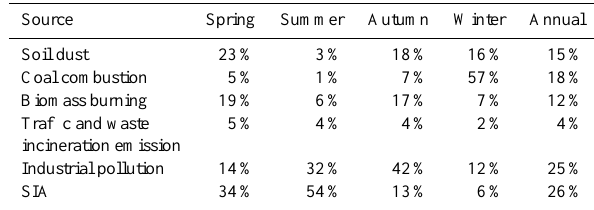
Table 2. Relative contributions from six identified sources of PM 2 . 5 in Beijing within the one-year and four-season